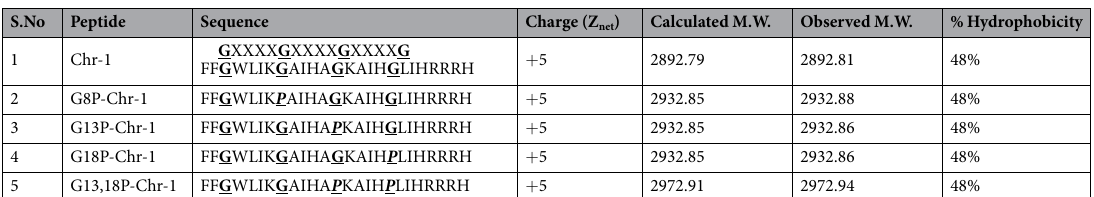
Table 2. Chrysophsin-1 (Chr-1) and its designed novel analogs with glycine residue(s) of GXXXXG motifs substituted with proline residue(s). Glycine residues of GXXXXG motifs are marked as bold and underlined letters whereas proline residues are marked in bold, underlined and